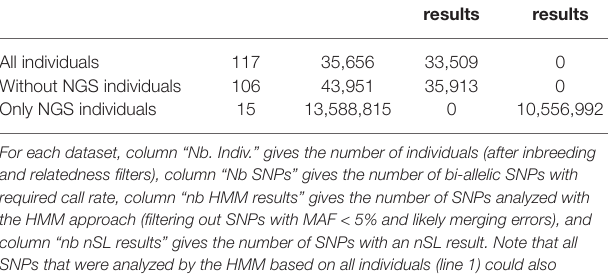
TABLE 1 | Summary of the datasets used for the selection scan.